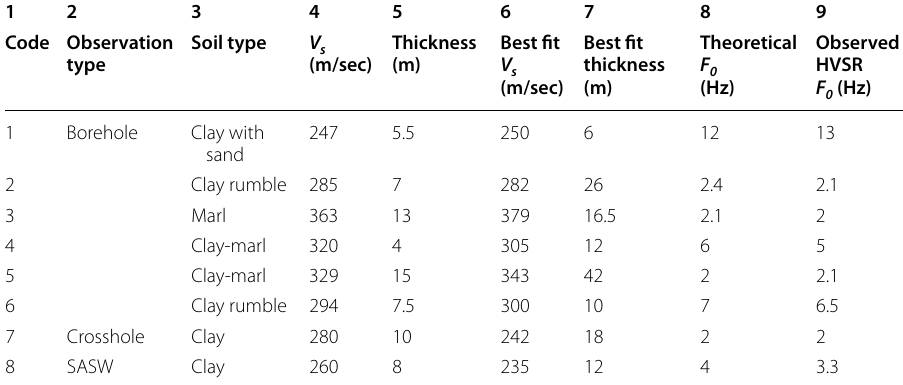
Table 2 Average subsoil characteristics deduced from geotechnical boreholes [51] and field measurements [39,